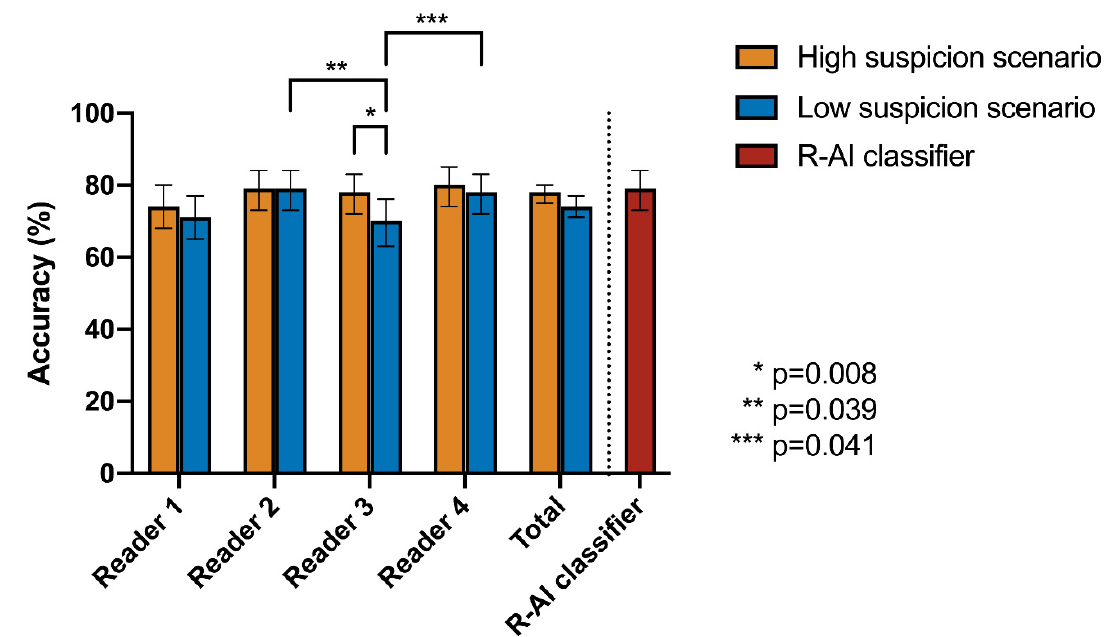
Figure 3. Comparison between the accuracy of the radiomic-based artificial intelligence (R-AI) classifier and the four readers in differentiating COVID-19 from other types of viral pneumonia in both high and low suspicion scenarios. Bars on graph boxes represent the 95% confidence interval of the accuracy values. Significant results of pairwise McNemar test after Bonferroni’s correction were reported. Table 3. Diagnostic performance of radiomic-based artificial intelligence classifier (R-AI) and human readers in classifying the patients in the high and low suspicion